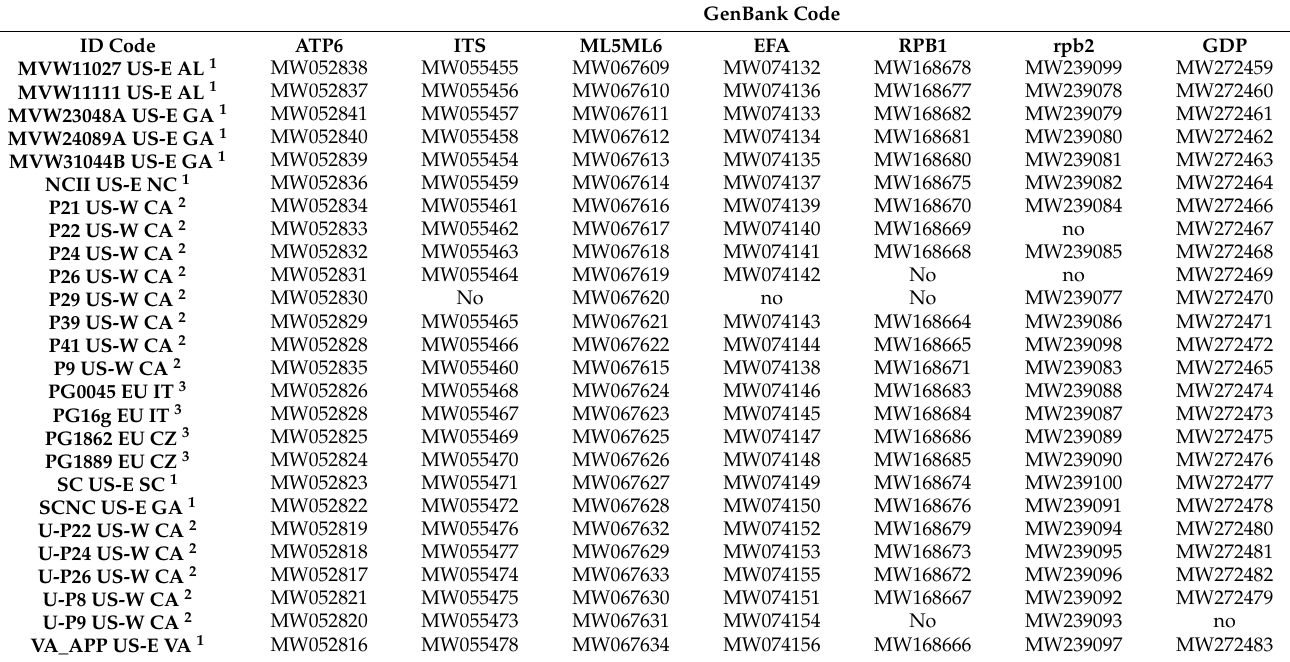
Overall, the analyses included 13 isolates from California, 9 isolates from the eastern US, four isolates from Europe and 45 GenBank accessions (Table 4 and Table S1). Table 4. GenBank accession numbers of newly generated Phlebiopsis gigantea